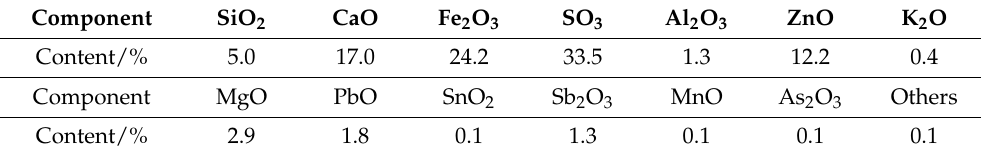
Table 2. Chemical components of Gaofeng